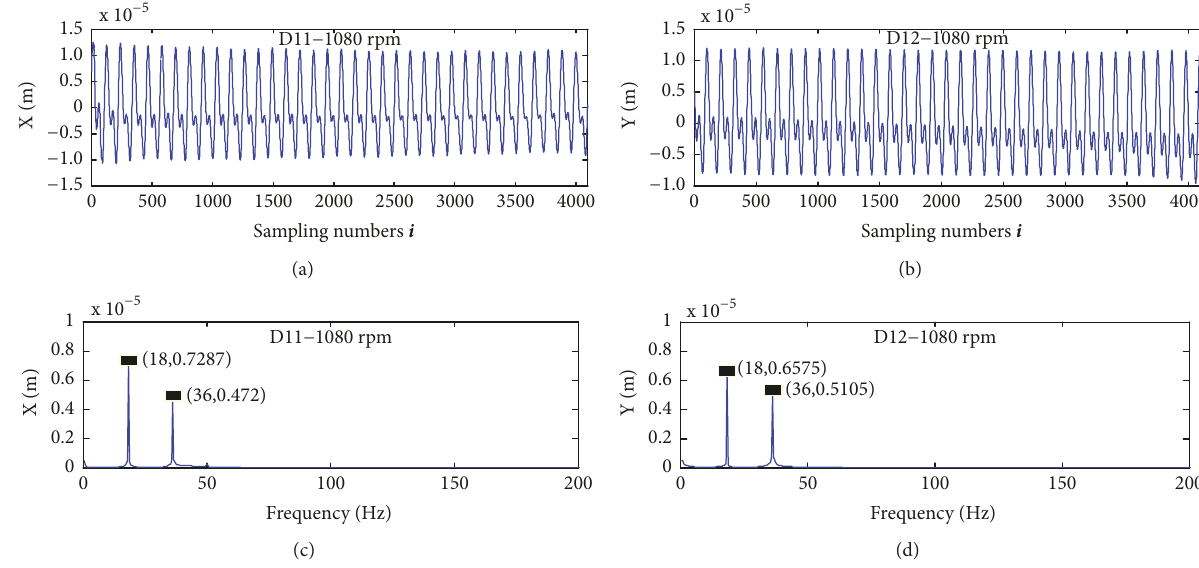
Figure 12: Extracting the time and frequency spectrums of the first two frequencies of D11 and D12. (a) The time domain of D11. (b) The time domain of D12. (c) The frequency domain of D11. (d) The frequency domain of D12.